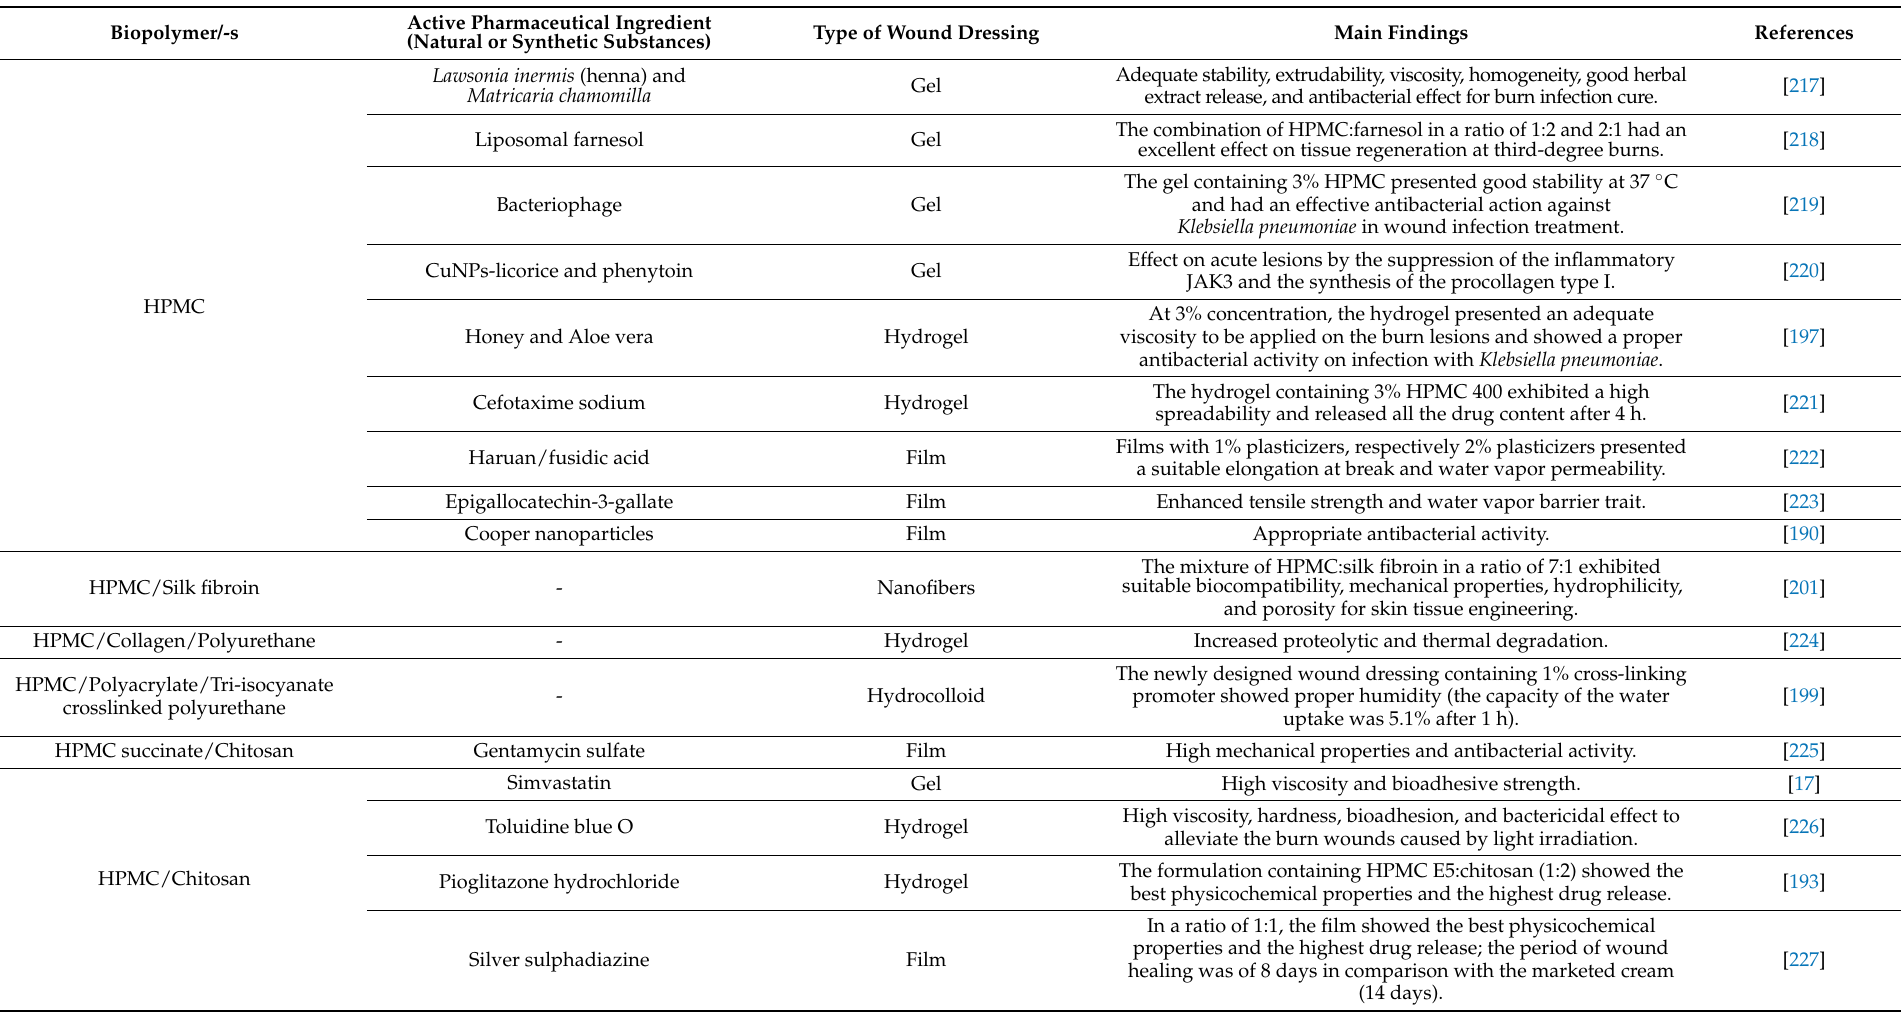
Table 4. Recent studies on the use of hydroxypropylmethylcellulose as a wound